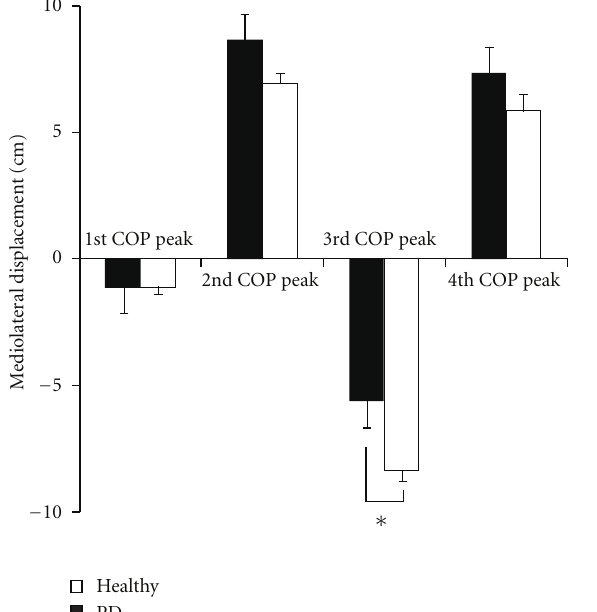
Figure 3: Mediolateral displacement of COP peaks. Data columns indicate the mean, and error bars indicate standard errors of the mean. An asterisk indicates a significant di ff erence between the groups ( P < 0 . 05).